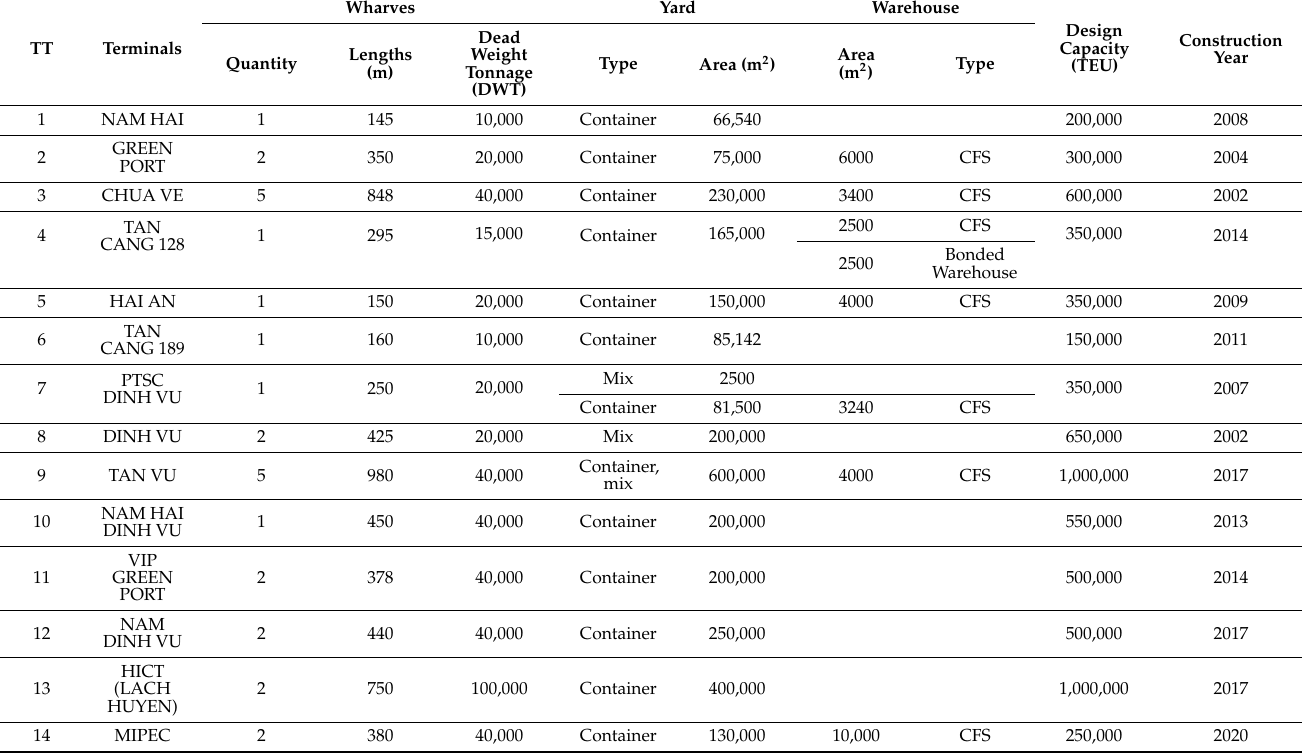
Table 1. Descriptions of container terminals in the North of Vietnam.